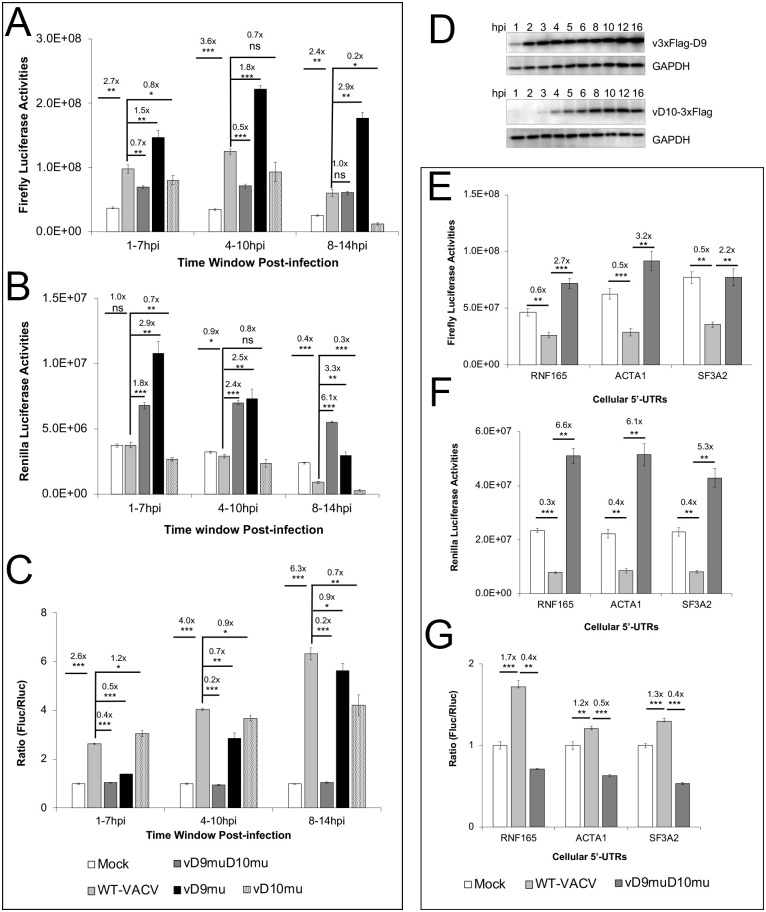
Inactivation of viral decapping enzymes substantially impairs selective translation of mRNA with a poly(A) leader during VACV infection.(A-C) Co-transfection of m7G-capped 12A-Fluc and Kozak-Rluc in WT, vD9muD10mu, vD9mu, and vD10mu-infected A549DKO cells at indicated time post-infection. Luciferase activities were measured 6 h post-transfection to evaluate the translation activities during the periods 1–7, 4–10, and 8–14 hpi, respectively. Fluc (A), Rluc (B), and Fluc/Rluc ratios with mock-infected samples normalized to 1 (C) are presented. (D) D9 and D10 expression over the course of VACV infection of A549 DKO cells at MOI 5. v3xFlag-D9 in which WT-D9 is tagged with a 3xFlag at N-terminus, and vD10-3xFlag in which WT-D10 is tagged with a C-terminal 3xFlag, were used, respectively. (E-G) Co-transfection of m7G-capped RNF165-, ACTA1- or SF3A-Fluc together with Kozak-Rluc in mock, WT-VACV-, and D9muD10mu-infected A549DKO cells at 8 hpi, respectively. Luciferase activities were measured 6 h post-transfection. Fluc (E), Rluc (F), and Fluc/Rluc ratios with mock-infected samples normalized to 1 (G) are shown. Error bars represent the standard deviation of 3 biological replicates. Significance determined by students t-test where p>0.05 (ns), p≤ 0.05 (*), p≤0.01 (**), and p≤0.001 (***). Numbers above significance represent fold change between compared samples.